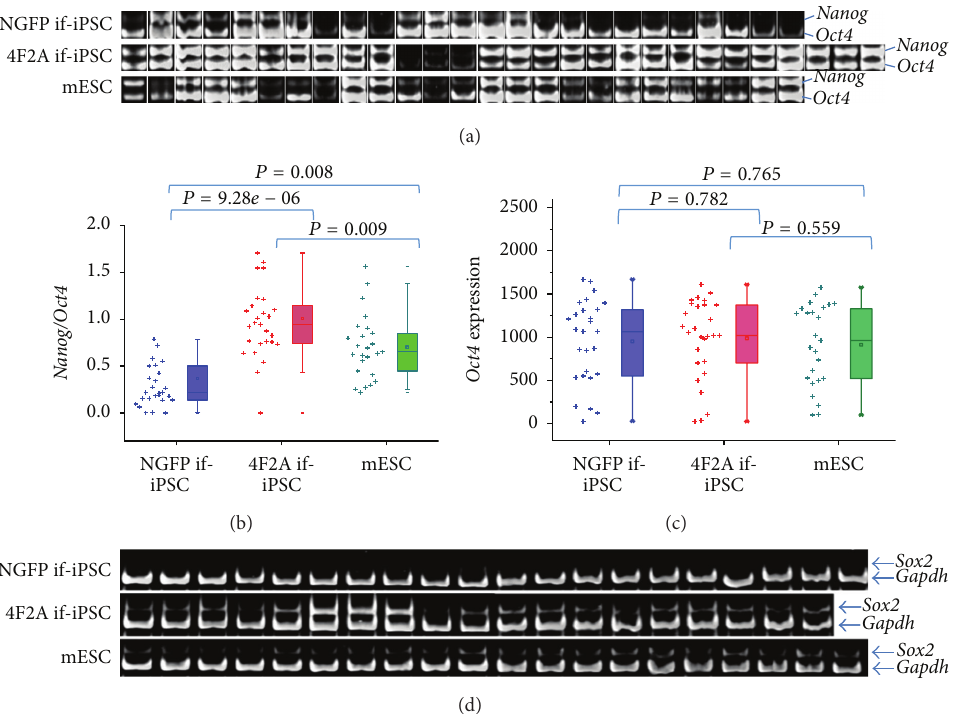
Figure4:Higherfrequencyofderepressionof Nanog and Sox2 genesin4F2Aif-iPSCcoloniesthanNGFPif-iPSCcolonies.(a)–(c)Expression levels of Nanog to Oct4 genes in NGF if-iPSC, 4F2A if-iPSC, and mESC colonies. Expressions of Nanog (upper band) and Oct4 (lower) in individual if-iPSC colonies are presented in gel images (a) and by statistics using a box-scatter plot (b). Oct4 expression levels are shown in (c). In (a) and (b) the expression levels of Nanog and Oct4 are of their own, not normalized with Gapdh . The values of individual colonies are shown as dots on the left of each box plot. The mean values are indicated in the boxes (circles). Box whiskers indicate the range from 5% to 95%. (d) Duplex RT-PCR showing expression levels of Sox2 relative to Gapdh in single colonies. Expression frequency is higher in 4F2A if-iPSC colonies than in NGFP if-iPSC colonies. The primer sets used were designed to specifically recognize 3 󸀠 -untranslated regions (UTR) of endogenous Oct4 , Nanog , and Sox2 genes which were absent in NGFP and 4F2A reprogramming cassettes. Gapdh , internal